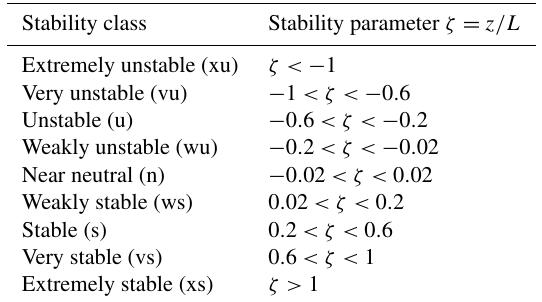
Table 2. Classification of atmospheric stability (Mohan,